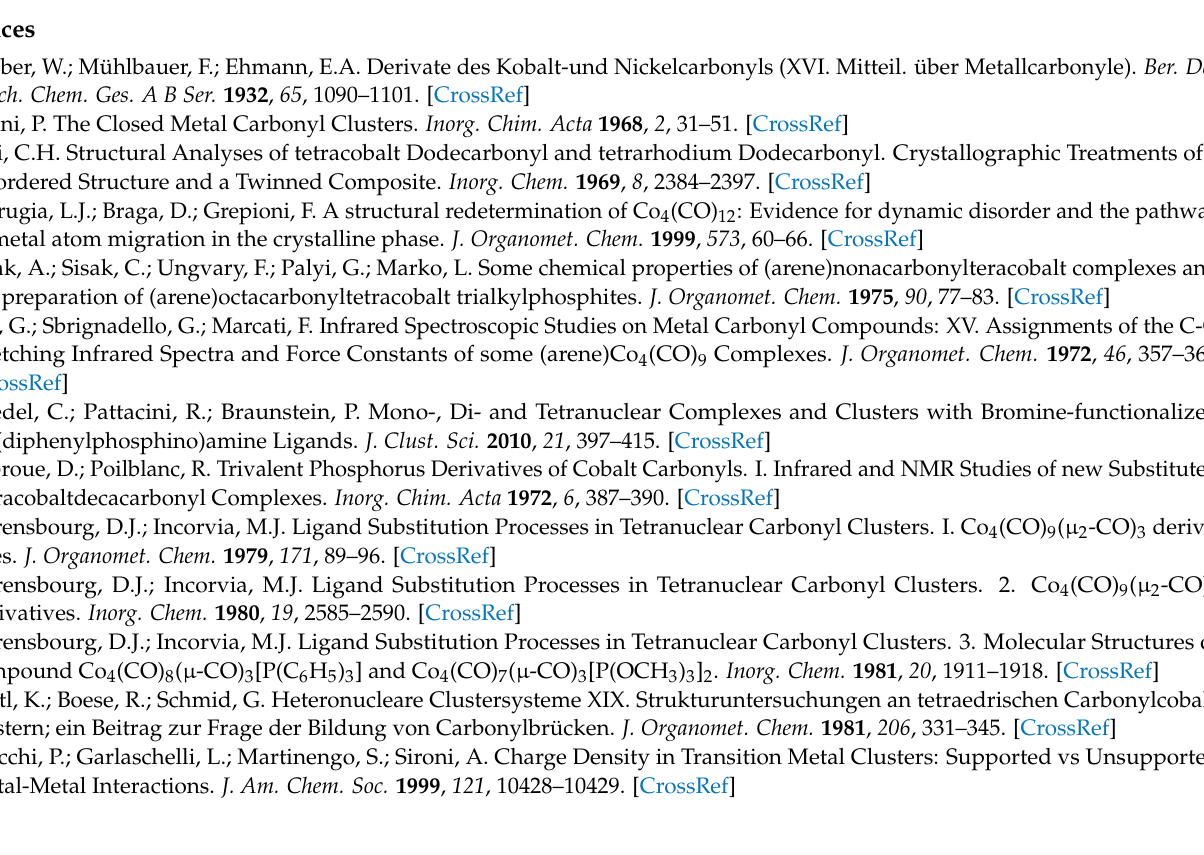
Figure S1: IR ATR spectrum of compound 2 ; CIF file and Check-CIF